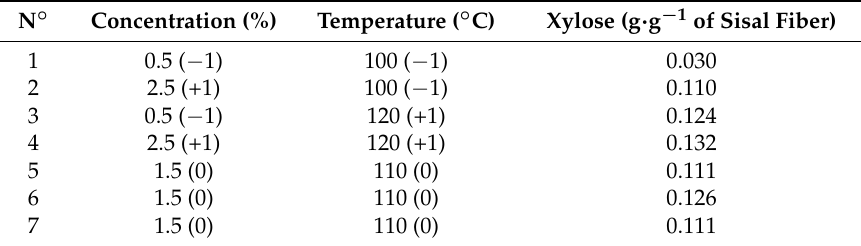
Table 1. Experimental design and amount of xylose extracted by acid pretreatment.